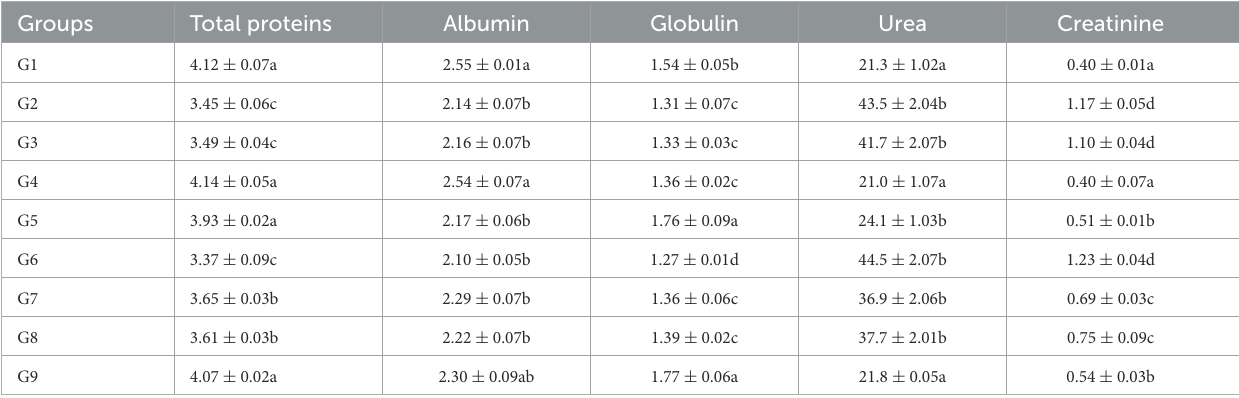
TABLE 4 Biochemical parameters (g/dL) of broiler chicks on day 21 experiment administered arsenic, chromium, vitamin E, and bentonite alone or in combination. Groups Total proteins Albumin Globulin Urea